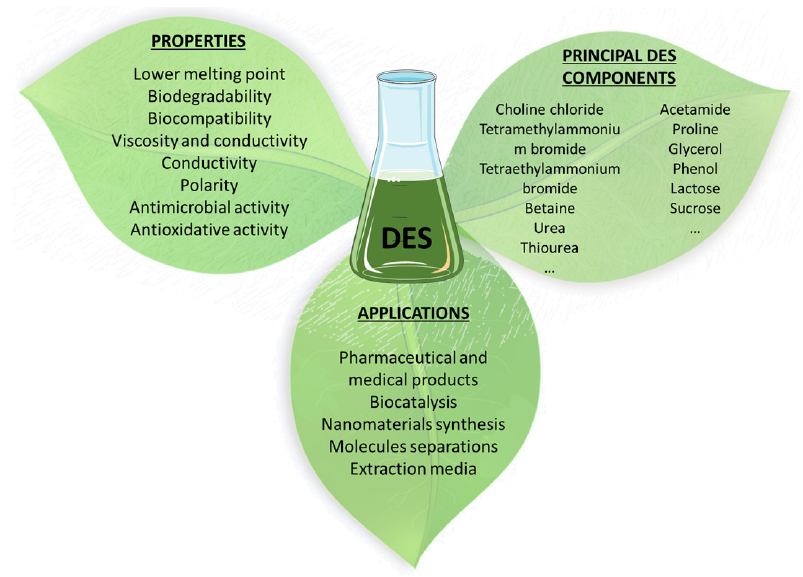
Figure 1. Properties and applications of the most important DESs.